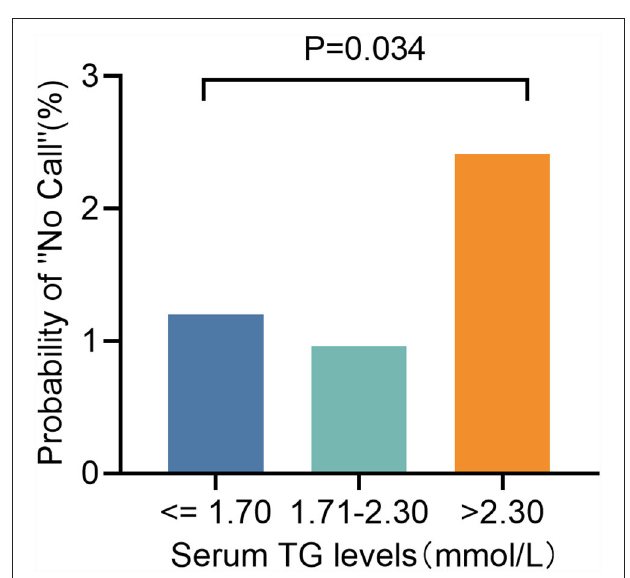
FIGURE 5 | Test failure rate according to different groups of TG.